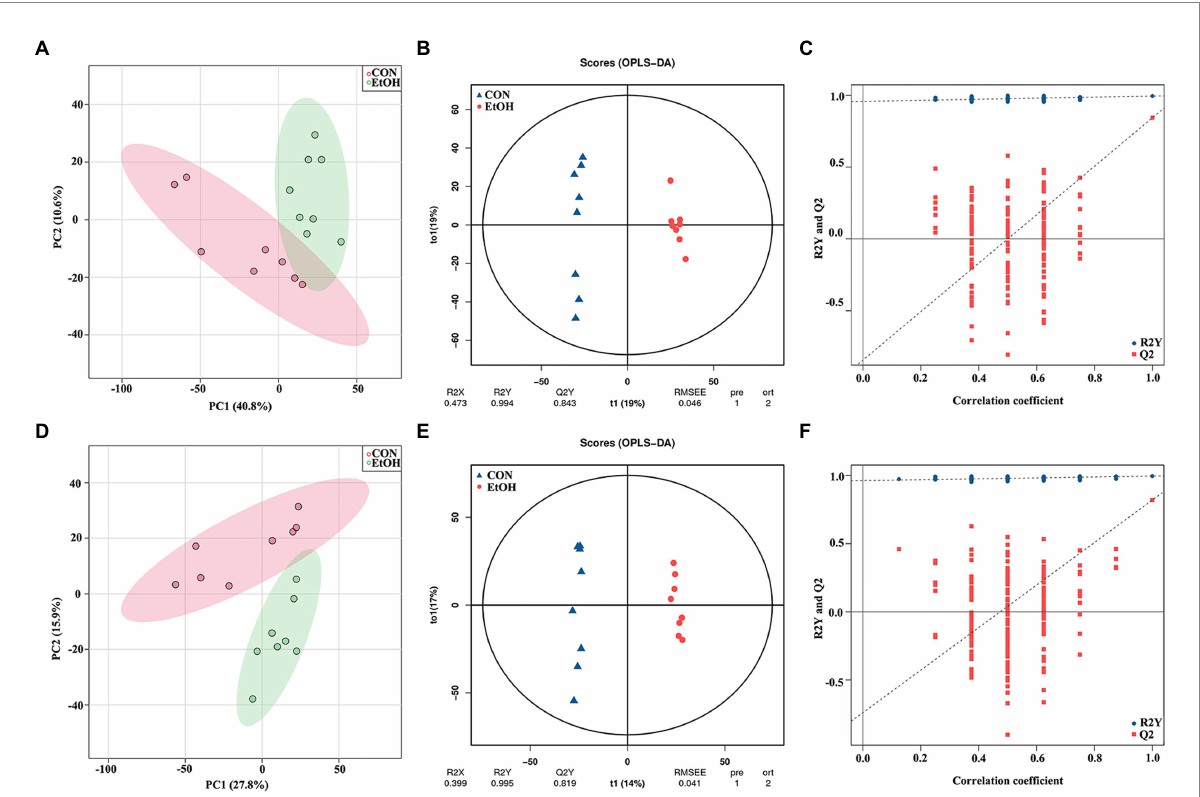
FIGURE 10 Multivariate statistical analysis of serum metabolites measured by untargeted metabolomics analysis at positive (A–C) and negative (D–F) ion mode. PCA analyses comparing metabolites of all samples between EtOH and CON group (A,D) ; OPLS-DA scores showed significant differences between EtOH and CON group (B,E) ; and the OPLS-DA permutation test confirmed the differences of serum metabolites in EtOH and CON group (C,F)